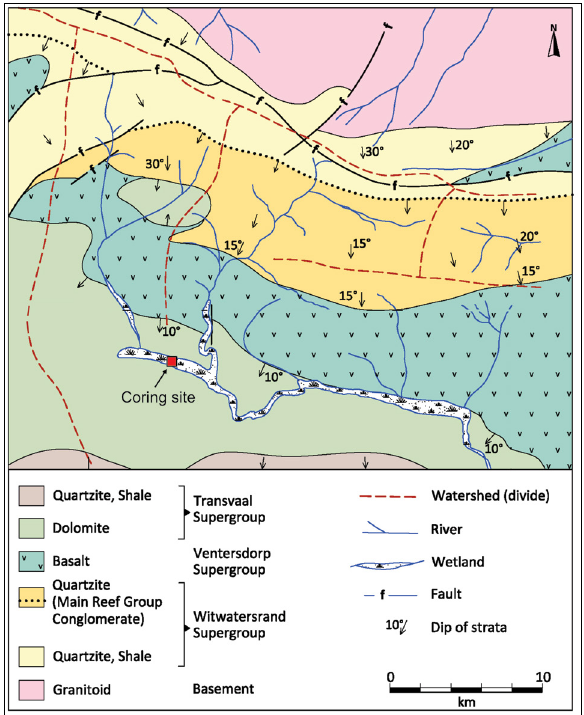
Figure 2: Simplified geology of the study area.